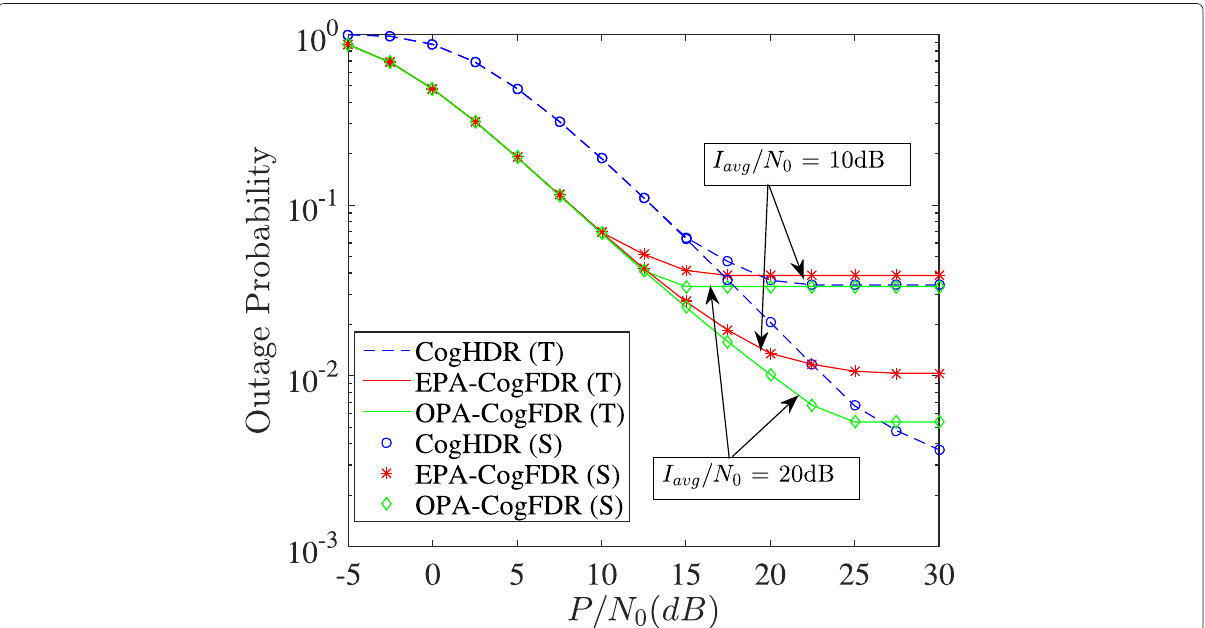
Fig. 5 Outage probability comparison with varying interference threshold power; P / N 0 = 20 dB ( λ rr = − 40 dB)